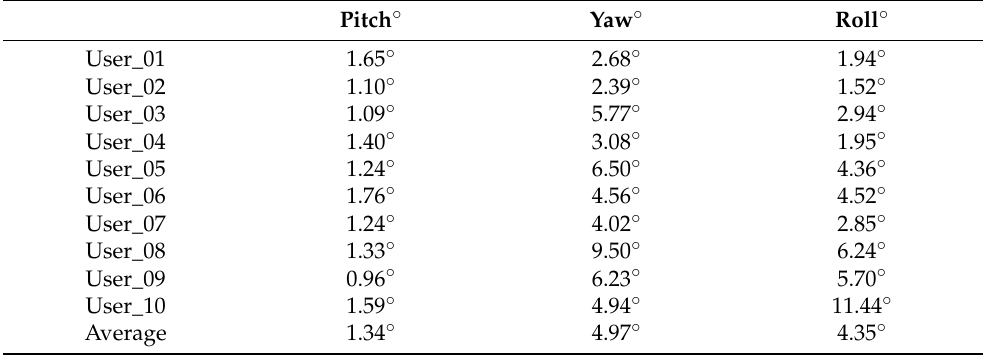
Table 3. Comparison of the angles taken from the UPNA Head Pose Database with the angles calculated by our